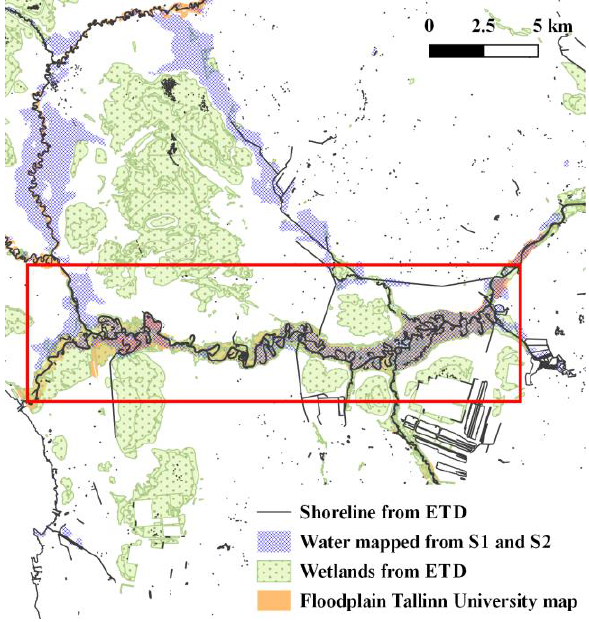
Figure 7. River Emajõgi at different maps